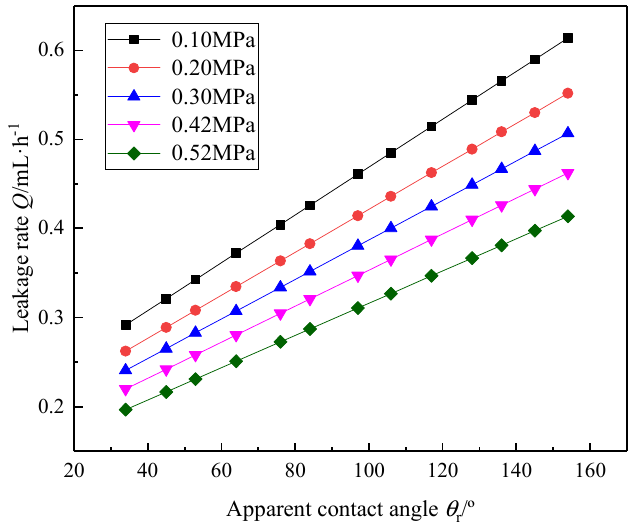
Figure 8. The influence of apparent contact angle on leakage rate under different contact pressures.